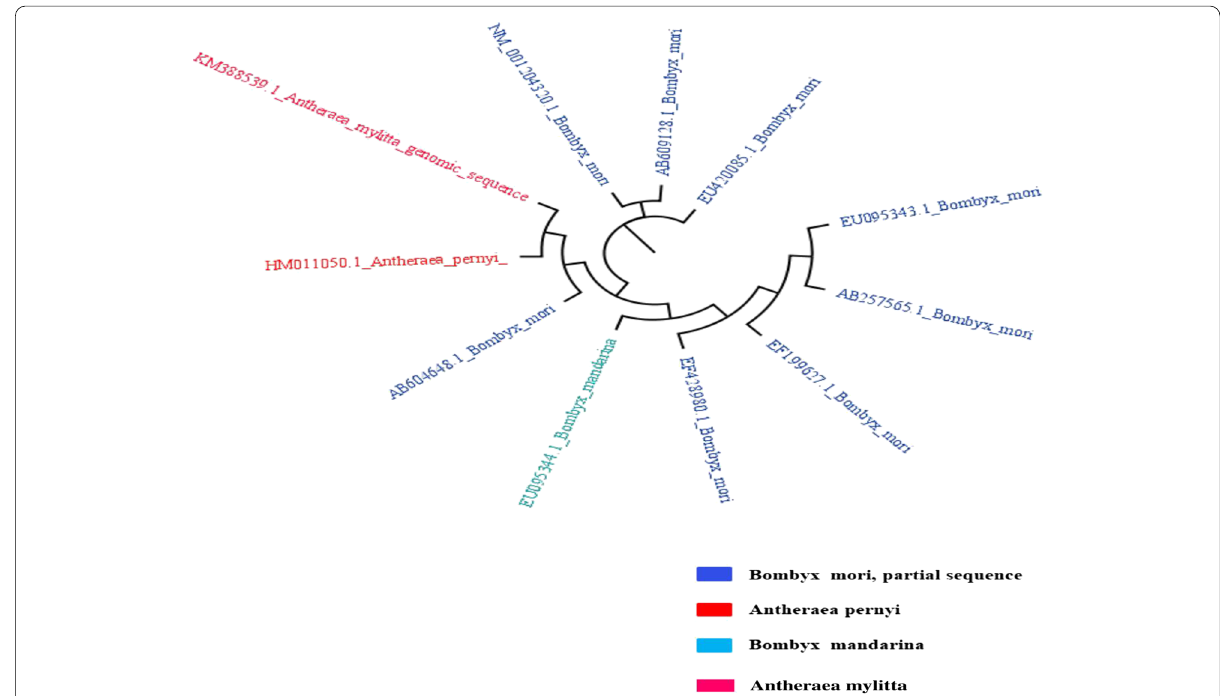
Fig. 4 Phylogenetic tree constructed with AmCoc (accession no.KM388539.1) and enlisted nucleotide cocoonase sequences from homologues